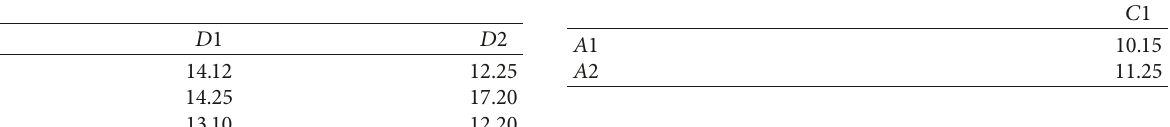
Table 3: Exponential mean cost from S1, S2, and S3 to D1 and D2 (in $).